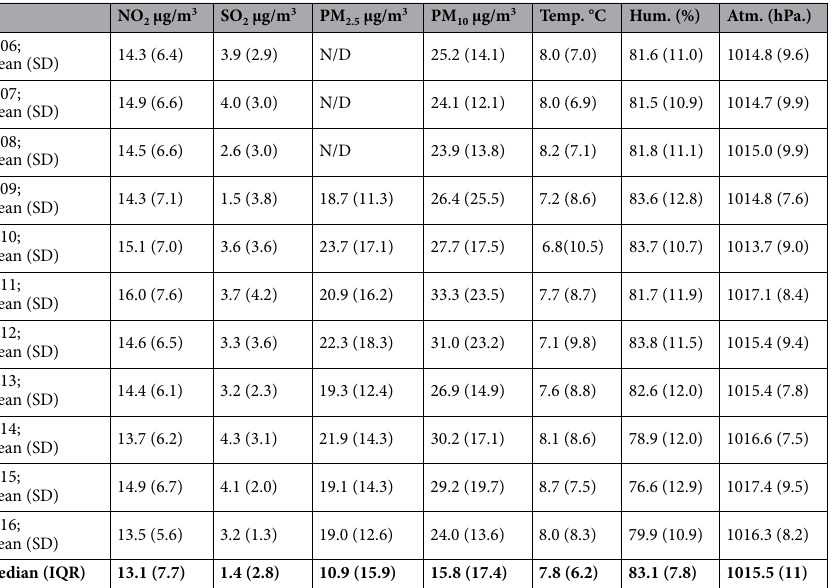
Table 3. Characteristics for yearly concentrations of air pollutants and weather conditions in the studied region. Abbreviations : IQR, interquartile range; N/A, not available; NO 2 , nitrogen dioxide; PM 2.5 , particulate matter with a diameter of 2.5 μm or less; PM 10 , particulate matter with a diameter of 10 μm or less; SD, standard deviation;